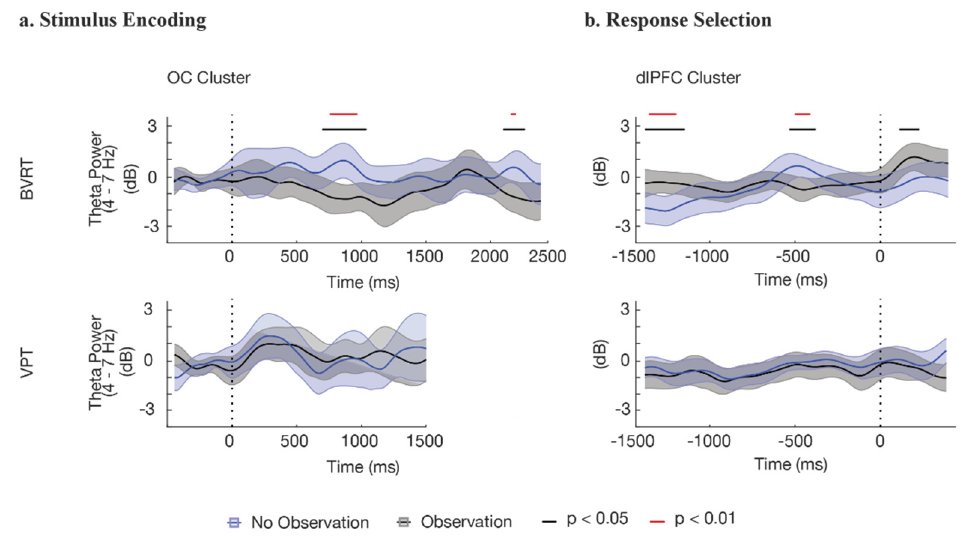
Figure 6. Theta-band (4–7 Hz) power for the observation and no-observation conditions, plotted with a 95% confidence interval. ( a ) during the stimulus period, the OC cluster showed significant power differences associated with observation conditions in the BVRT at approximately 725–1075 ms. No corresponding significant differences were observed in the VPT. ( b ) During the response period, the dlPFC cluster showed significant differences associated with observation conditions in the BVRT at approximately 400–500 ms prior to the response. No corresponding significant differences were observed in the VPT.